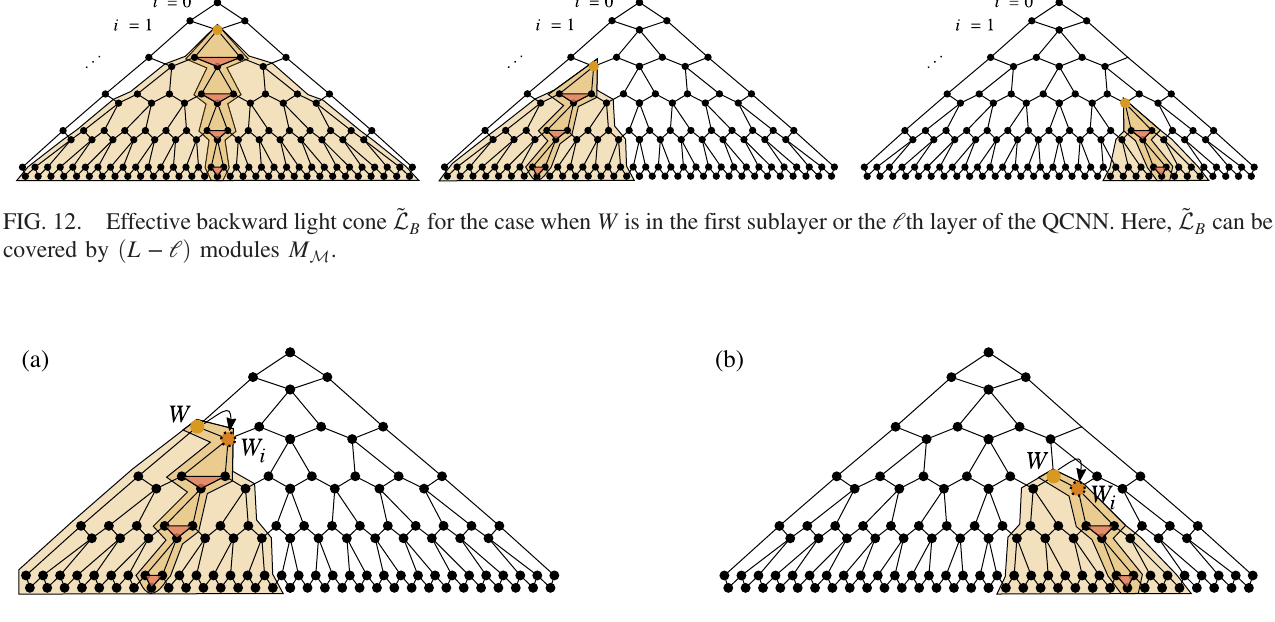
FIG. 13. (a) The unitary W is in the edge of the second sublayer. Here all unitaries in the backward light cone modules M M except for the initial unitary W structure is similar to the one in panel